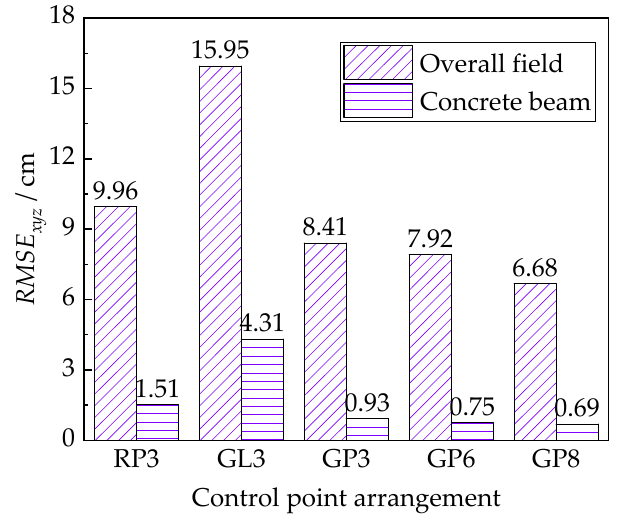
Figure 9. The effect of control point arrangement on 3D model quality.